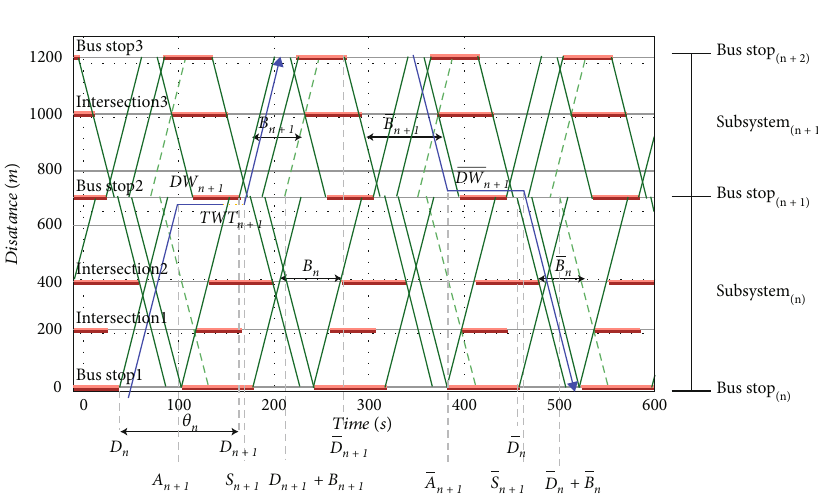
Figure 5: Variables used to optimize the combination between subsystems (symbols de fi ned in Tables 2).